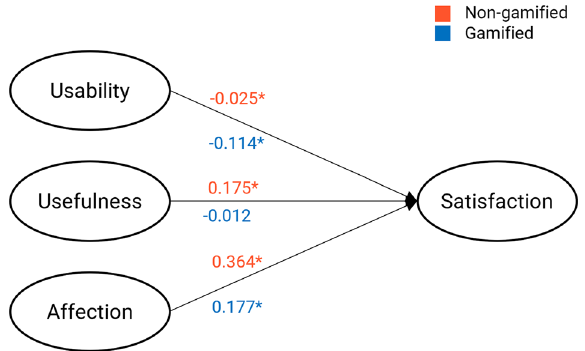
Fig. 2 Summary of the results in Study 1 ( β ); * p -value is lower than 0.05.